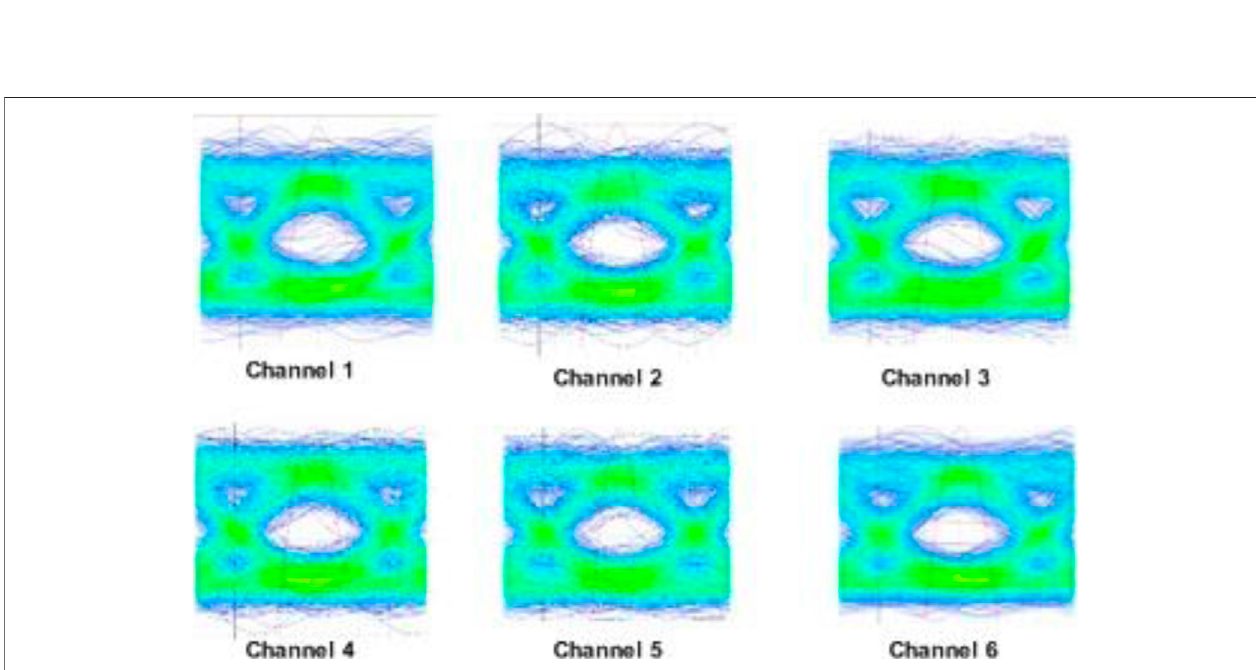
FIGURE 4 | Computed eye diagrams for all channels at the diffuse link of 200 cm.